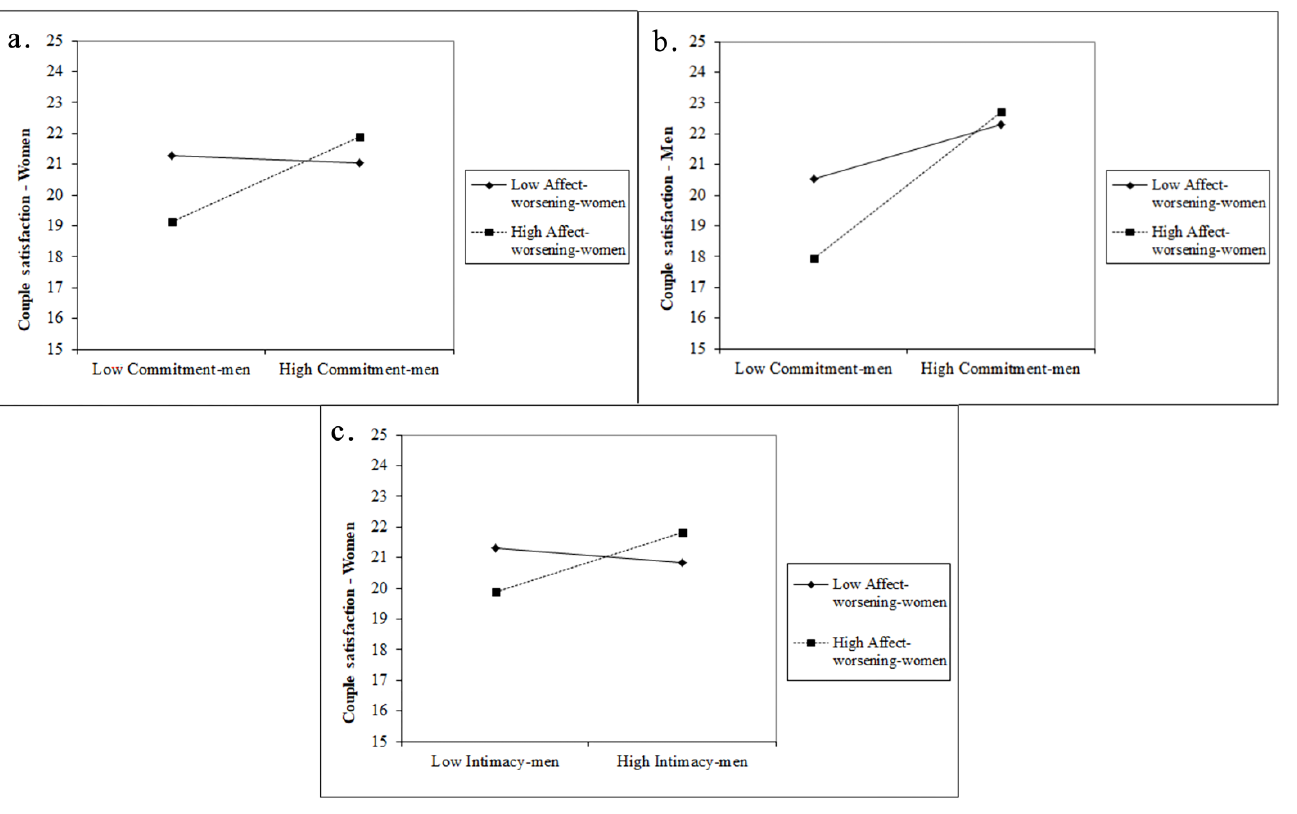
Figure 4. Women and men’s couple satisfaction with men’s low and high commitment ( a , b ) intimacy ( c ) for women that use less vs. more interpersonal affect-worsening strategies .